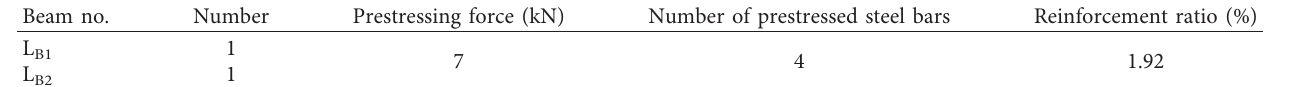
Table 3: Basic information of the control group.